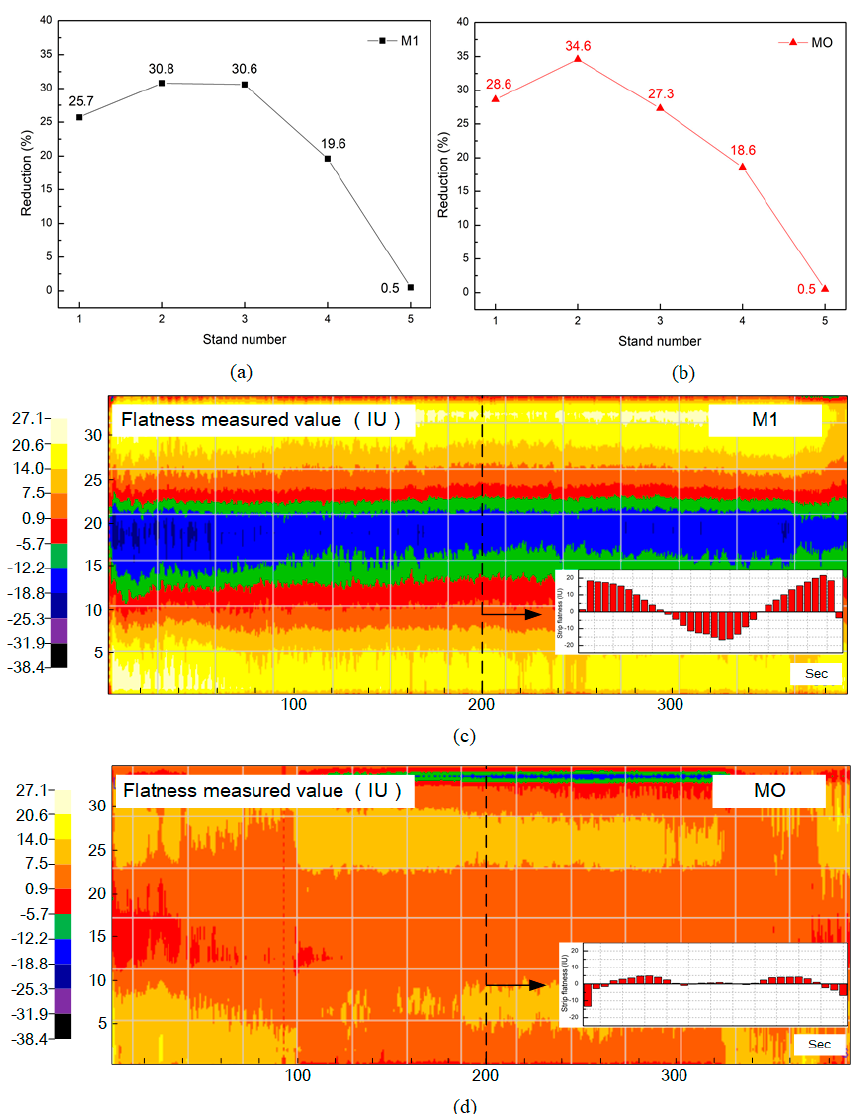
Figure 14. The load distribution of ( a ) M1 and ( b ) MO. The actual measured flatness values of ( c ) M1 and ( d )